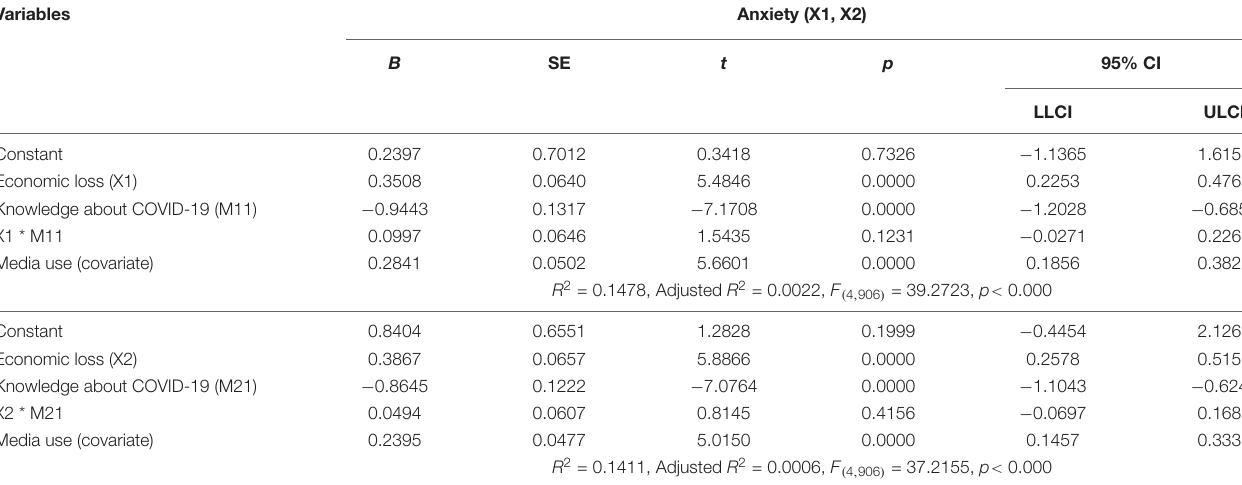
TABLE 4 | The moderating effects of knowledge about COVID-19 on the relationship between economic loss and anxiety. Variables Anxiety (X1,